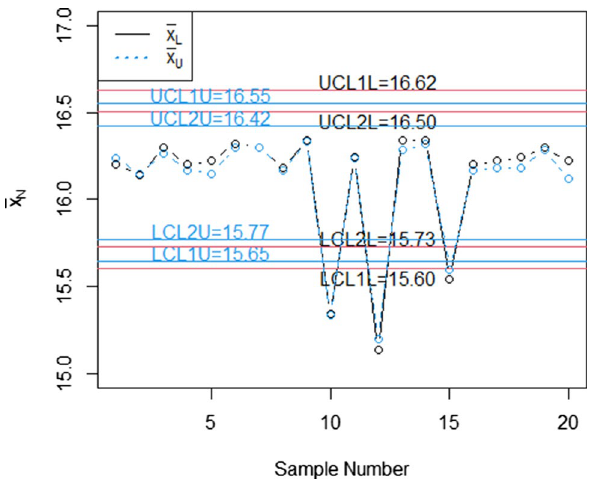
Fig. 5 The proposed control proposed by [30] for the real data